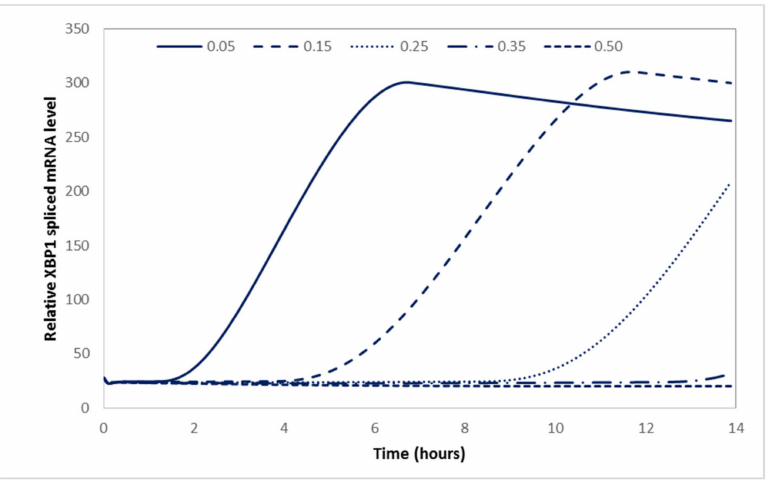
Figure 7. Effect of valproate in APP S stressed cells during Tm treatment. Simulation results for APP S show the effect of VPA on spliced XBP1 mRNA levels by means of varying BiP transcriptional ) rates ( β B m